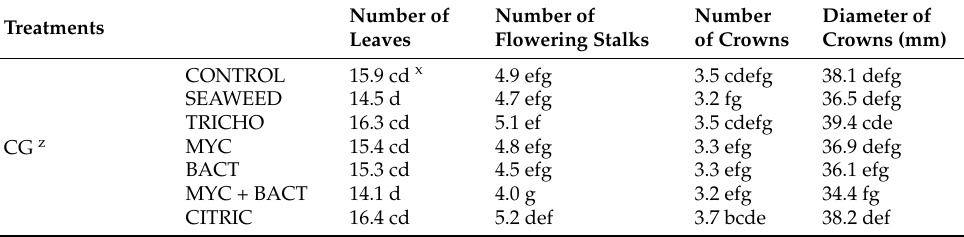
Table 2. Influence of biostimulant treatments on non-destructive growth parameters of strawberries grown conventionally and organically under a greenhouse and high tunnel during winter and summer